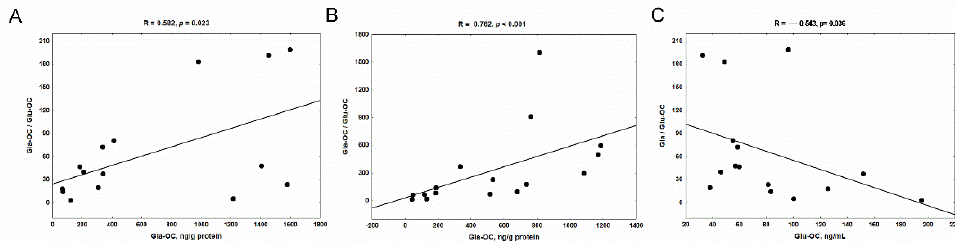
Figure 5. The associations between carboxylated osteocalcin (Gla ‐ OC) and Gla ‐ OC/Glu ‐ OC ratio in trabecular ( A ) and cortical ( B ) bone tissue; the relations between trabecular Gla ‐ OC/Glu ‐ OC ratio and serum undercarboxylated osteocalcin (Glu ‐ OC) levels; ( C ) in rats with chronic kidney disease (CKD).